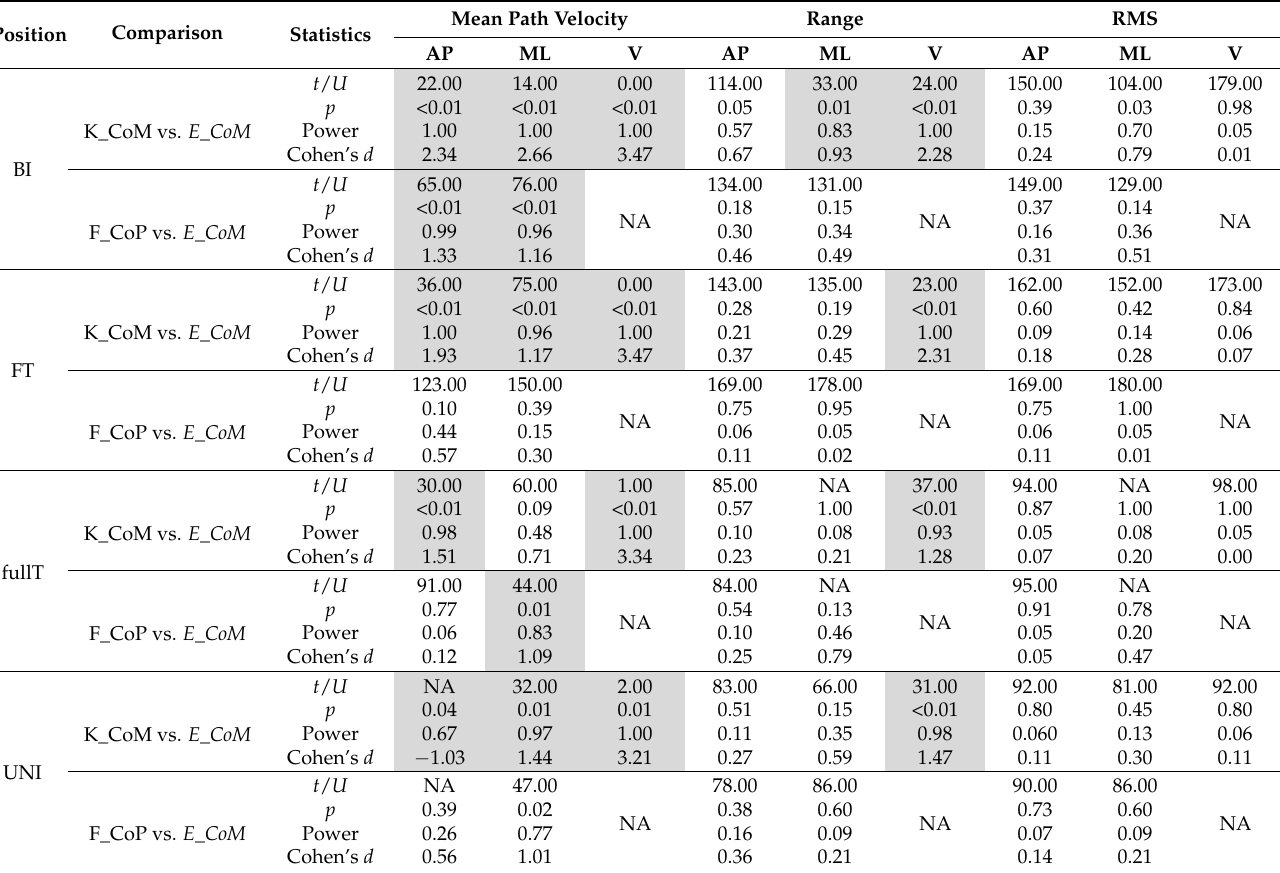
Table 5. Statistical results, power, and effect size for the comparison between Equimetrix CoM ( E _ CoM ) and the kinematic CoM (K_CoM) and force platform CoP (F_CoP) for the anterior–posterior (AP), medial–lateral (ML) and vertical (V) components of the one-dimension